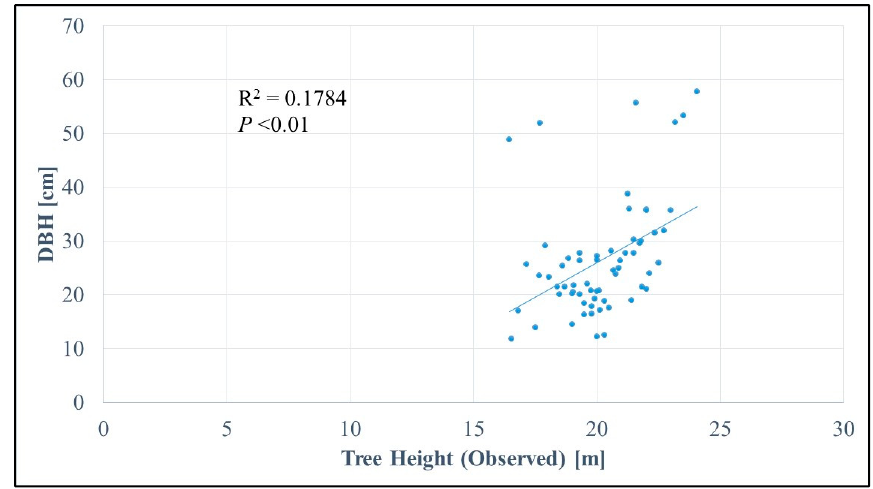
Figure 6. Analysis of the relationship between observed tree height (m) and Diameter at Breast Height (DBH) (cm). At larger DBH values, observed tree height does not correspond to the growing trend (outliers).